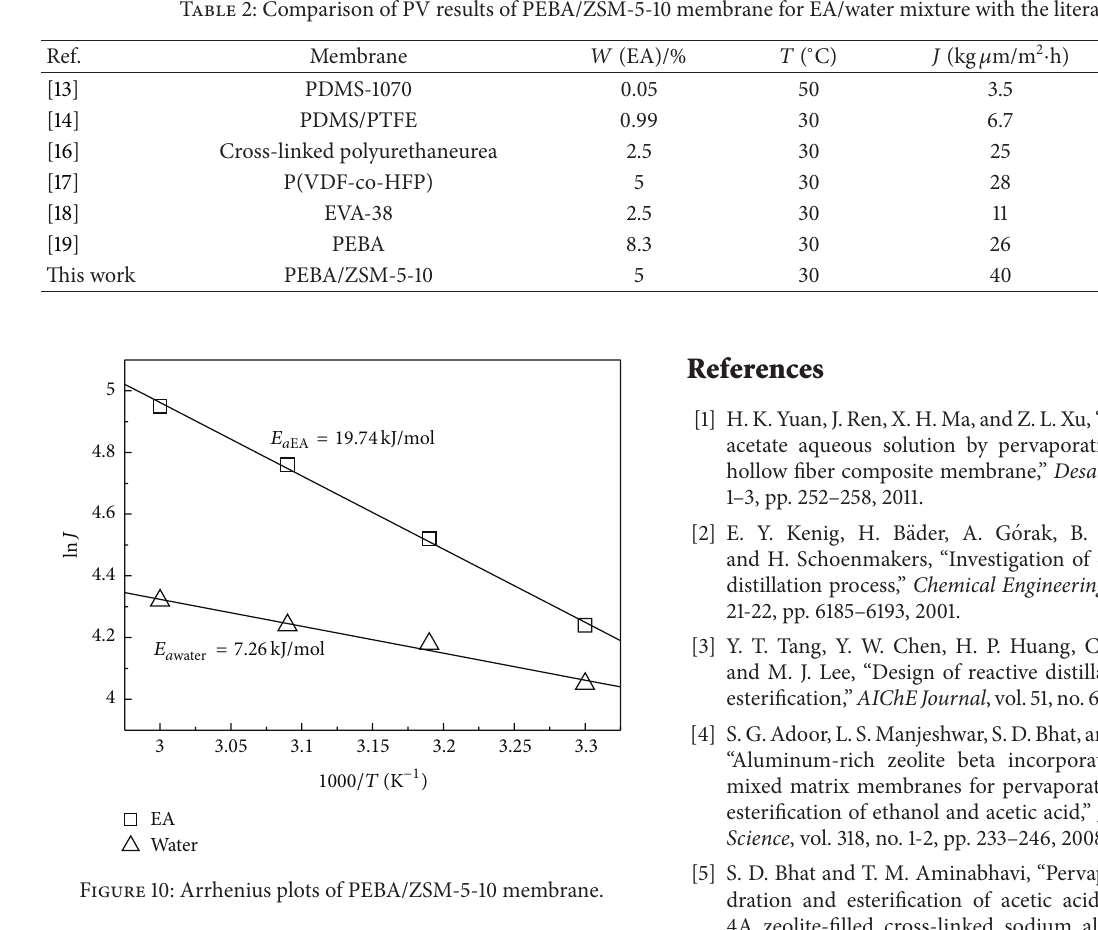
EA permselective. The PEBA/ZSM-5 membranes containing 10 wt% ZSM-5, that is, PEBA/ZSM-5-10, showed the highest separation factor at 30 ∘ C. With the increase of the operating temperature and feed concentration, both the permeation flux and separation factor increased except when the tem- perature exceeded 50 ∘ C. The best PV performance, separa- tion factor, and total flux of the PEBA/ZSM-5 membranes containing 10 wt% ZSM-5 were 185.5 and 199.5 gm −2 h −1 , respectively, with feed concentration of 5 wt% EA at 50 ∘